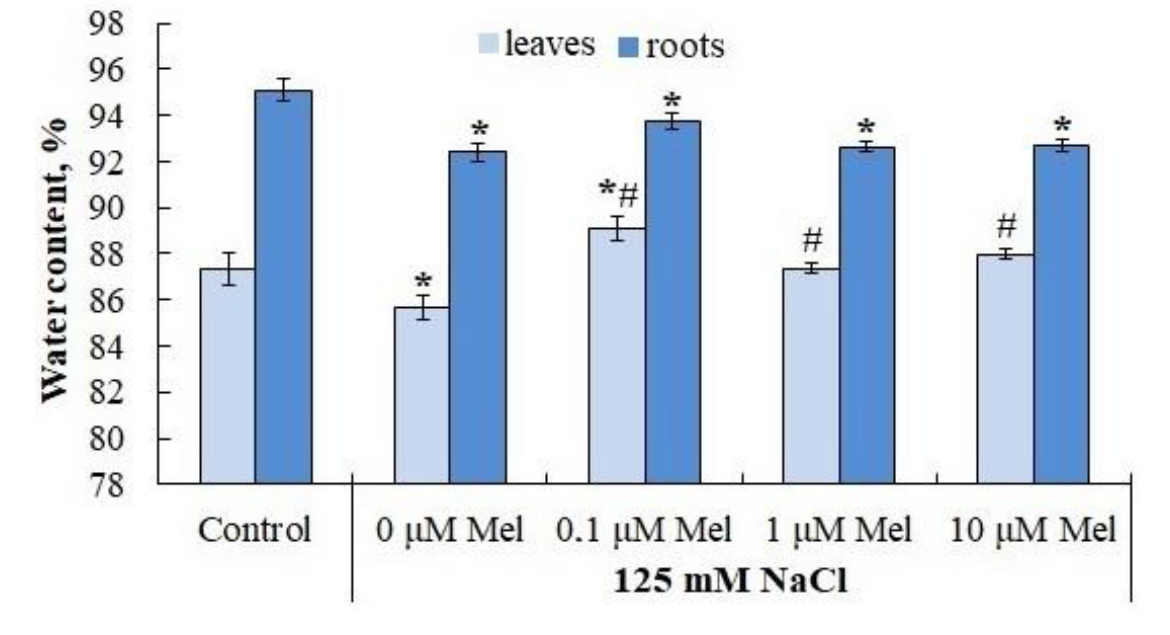
Figure 3. Influence of melatonin and chloride salinity on the water content (% of fresh weight) in leaves and roots of Solanum tuberosum plant. Asterisks (*) indicate significant differences from the control variant and the «#» indicates significant differences from the «125 mM NaCl» variant ( p < 0.05).